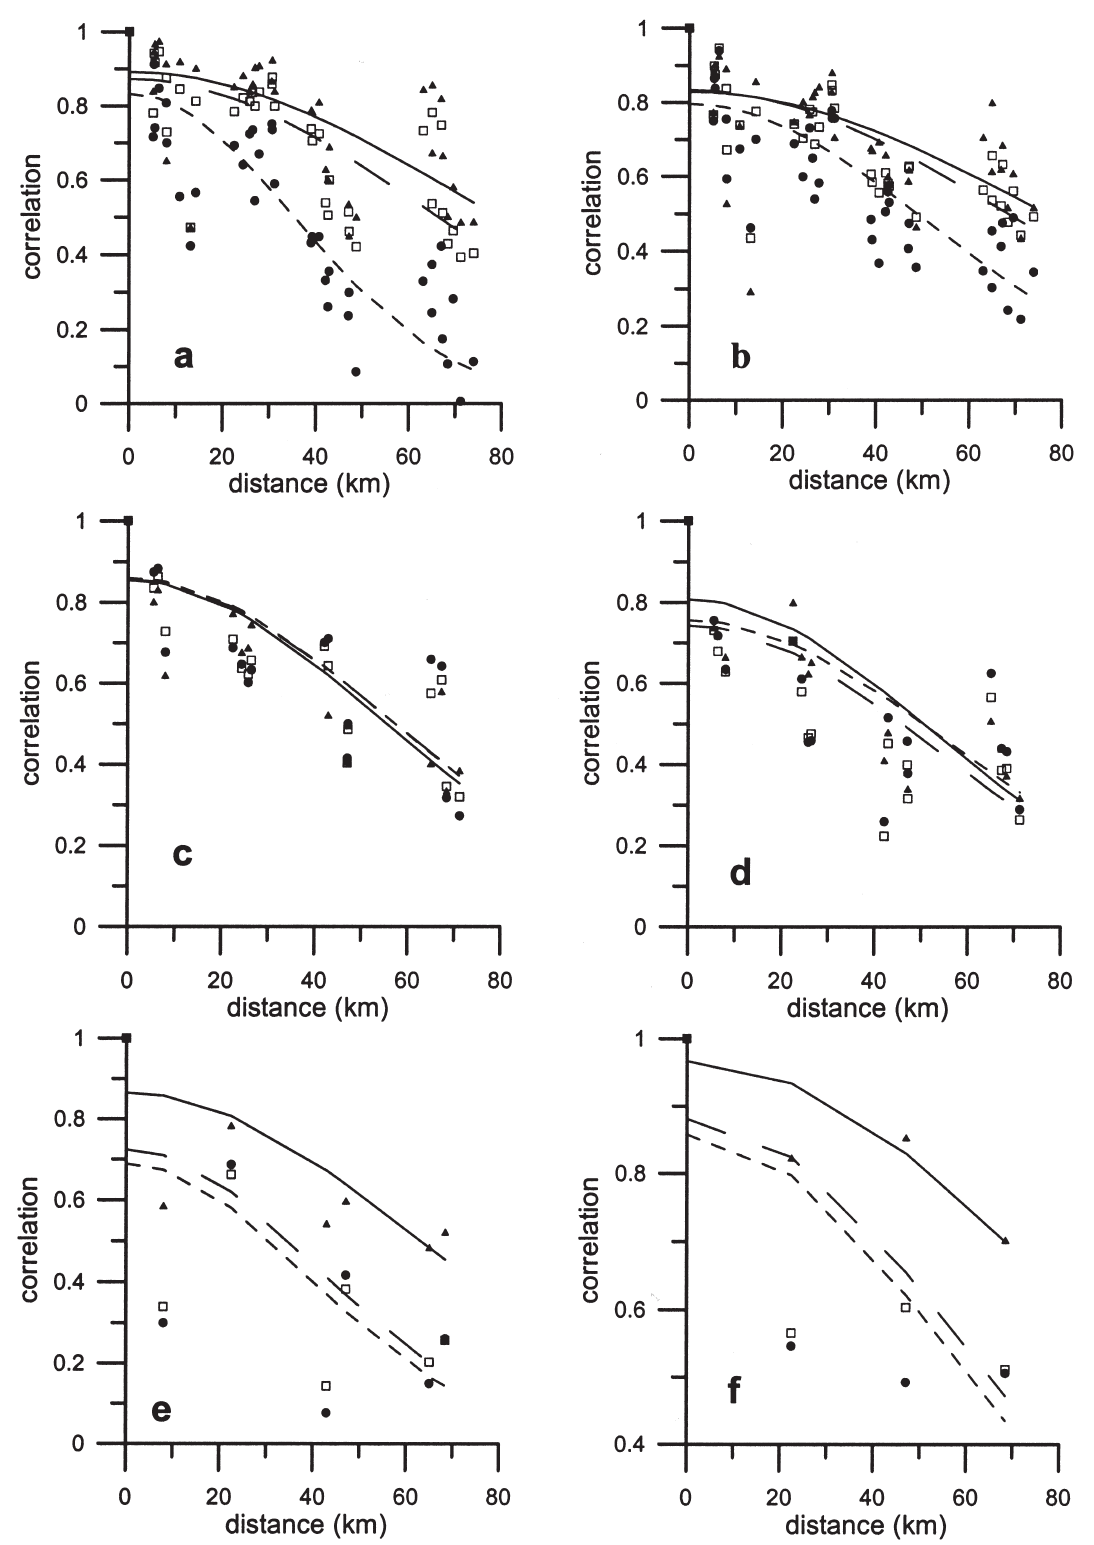
Fig. 3. – Correlation versus distance for 5, 25, 50, 75, 100 and 200 db (a, b, c, d, e and f respectively). In all the figures we include the cor- relation for temperature (triangles), salinity (circles) and svan (open squares) and the fit using a function of the form 2 r .The solid line is the fit for temperature, the dashed line for salinity and broken line for svan . 2 2 L x R e 0